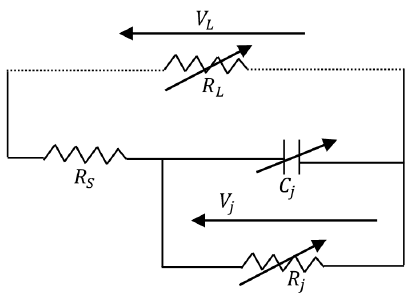
Figure 9. Small signal model of a Schottky diode [40,41].